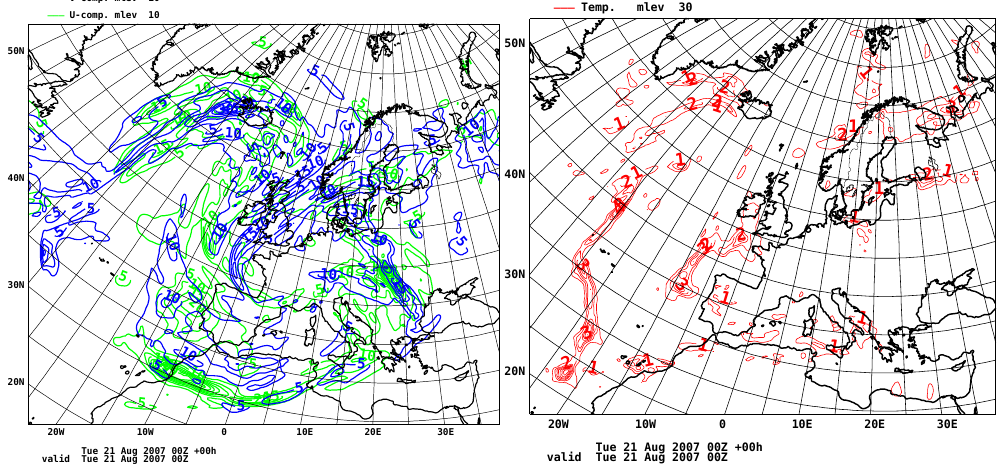
Fig. 4. Examples of estimated background error variance fields based on the ensemble of +6h forecast valid at 21 August 2007 12UTC from the hybrid data assimilation experiment hybrid 50. Wind components at model level 10 (approximately 300 hPa, left) and temperature at model level 30 (approximately 850 hPa, right). Isoline spacing 5 m 2 s − 2 and 1 K 2 .